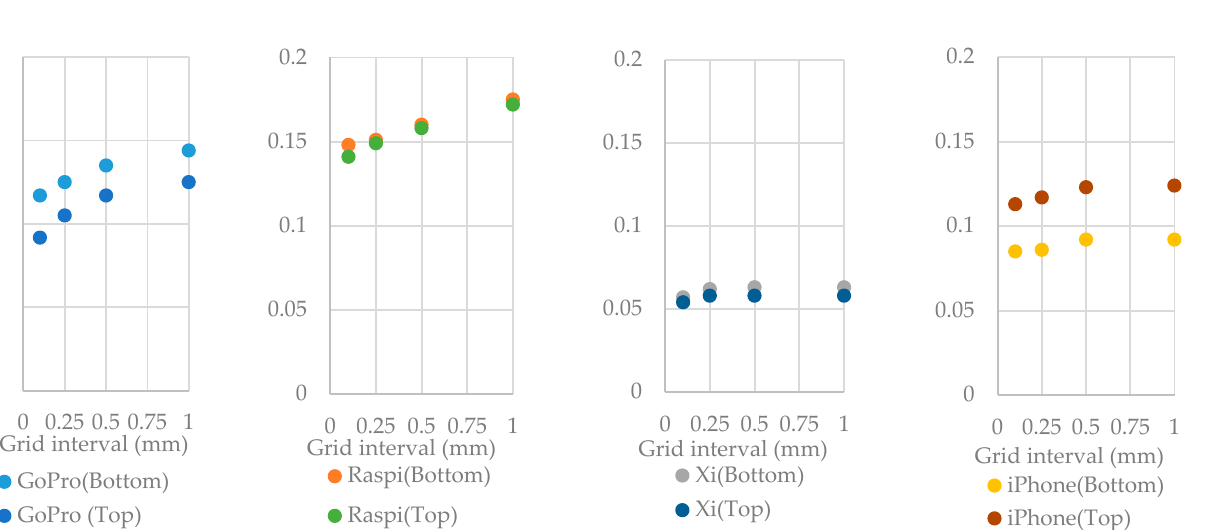
Figure 7. Surface density of the bottom surface in the 3D models.